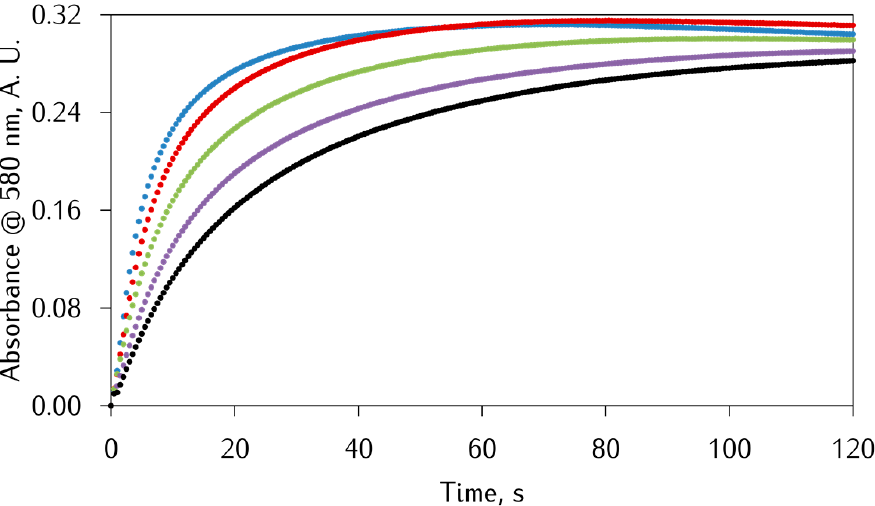
Figure 2. Kinetic traces of DA-Fe II (2:1) interaction as a function of Ac- α S 119–132 concentration ( λ max = 580 nm) in 10 mM Mops buffer pH 7.0, 37 ◦ C, Fe II 0.1 mM, DA 0.2 mM (blue), and increasing amounts of Ac- α S 119–132 (0.5 equiv.: red, 1 equiv.: green, 1.5 equiv.: purple, 2 equiv.: black).